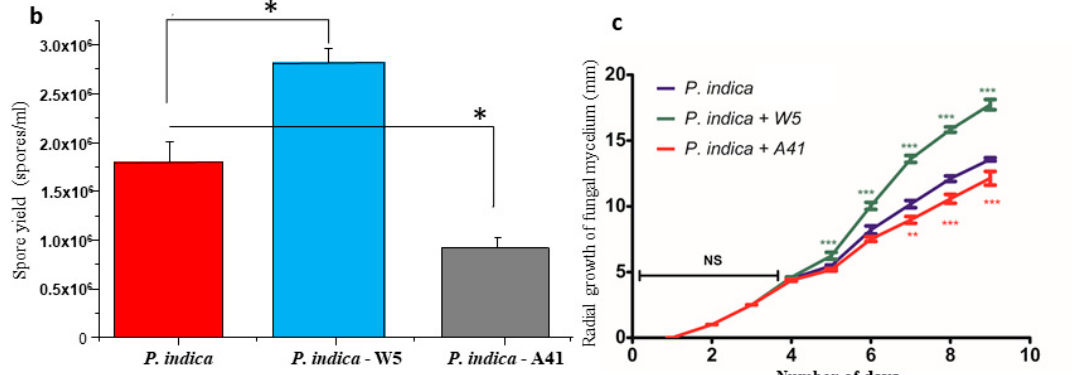
Figure 1. ( a – c ). Growth of P. indica was enhanced in the presence of A. chroococcum strain W5, while growth was observed to be inhibited in the presence of A. chroococcum strain A41. ( a ) Impact of two A. chroococcum strains on P. indica radial growth pattern. ( b ) Yield of chlamydospores in the presence of strains W5 and A41. ( c ) Radial growth of mycelium in the presence of strains W5 and A41. P -values indicate significant change in growth and spore yield in the presence of two strains ( n = 3, p -value * ≤ 0.05, ** ≤ 0.01 and *** ≤ 0.001) compared to the control ( P. indica ). Standard error (SE) is represented by error bars, while NS represents ‘not significant’.